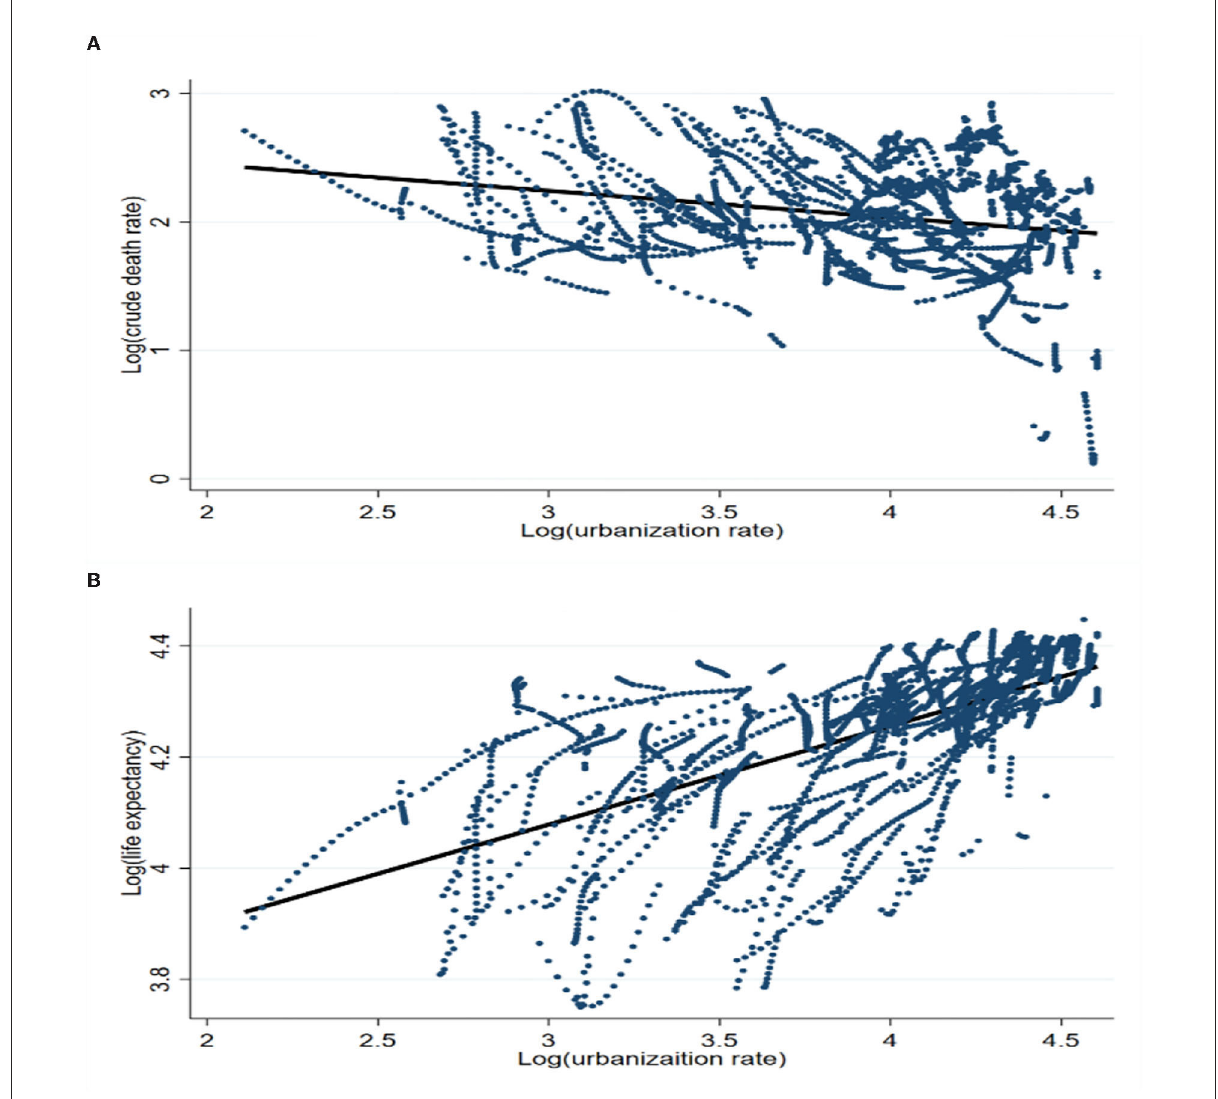
FIGURE2 Health indicators and urbanization rate. (A) Crude death rate vs. urbanization rate. (B) Life expectancy vs. urbanization